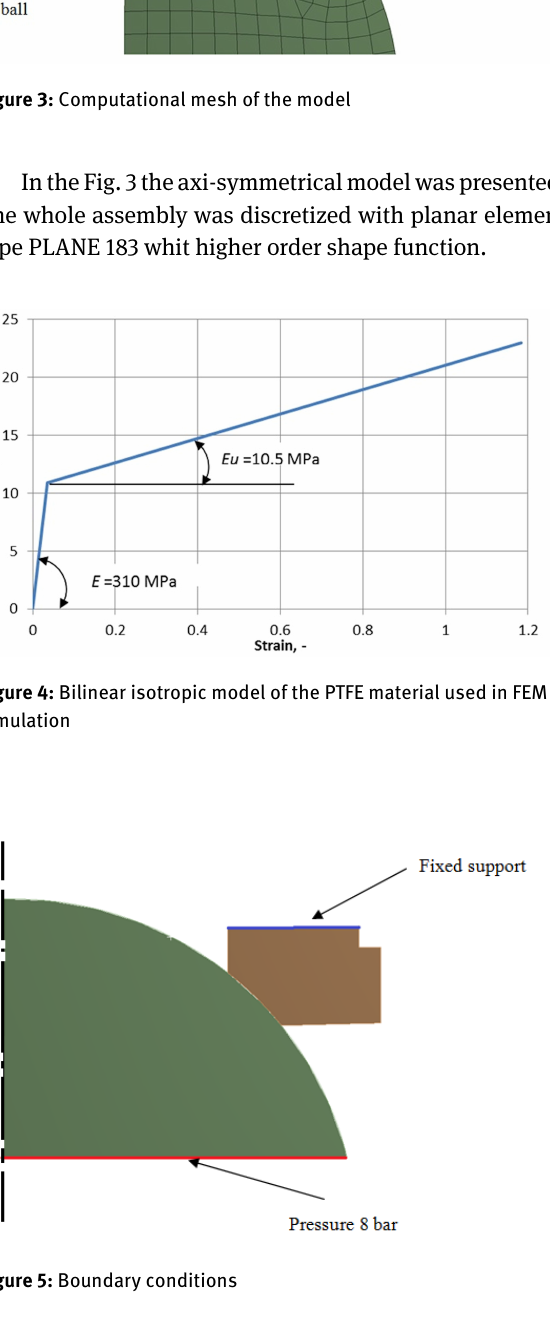
Figure 5: Boundary conditions